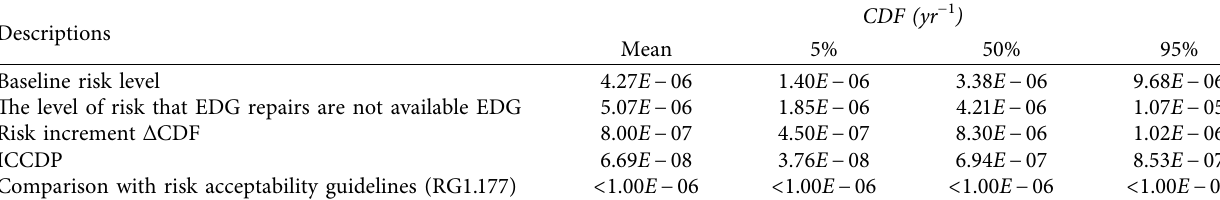
Table 2: Extension of EDG AOT efects ICCDP in